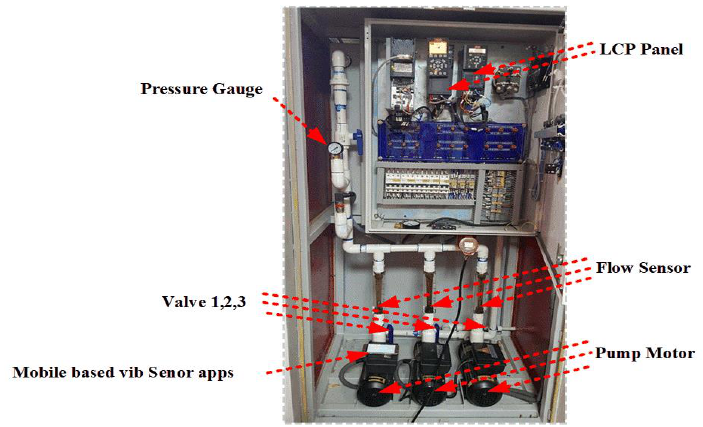
Figure 3. VFD-based multistage pumping system block diagram.